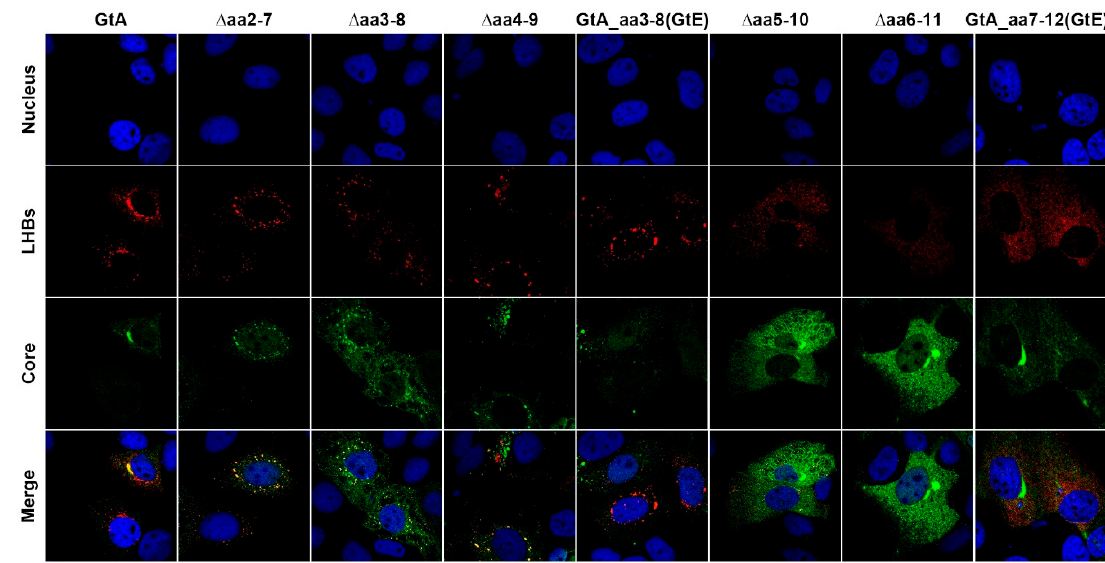
Figure 7. C-terminal deletions and substitution in 11 aa change the pattern of subcellular LHBs distribution. Huh7.5 cells overexpressing genome GtA and the derivatives were analyzed by confocal laser scanning microscopy (CLSM) using the LHB-specific monoclonal MA18 / 7 and core-specific polyclonal antiserum (Dako). Nuclei were stained with DAPI (blue). The merge of the fluorescences were shown in the right column. The figures showed a representative result; comparable data were obtained for the analysis of 10 different cells.